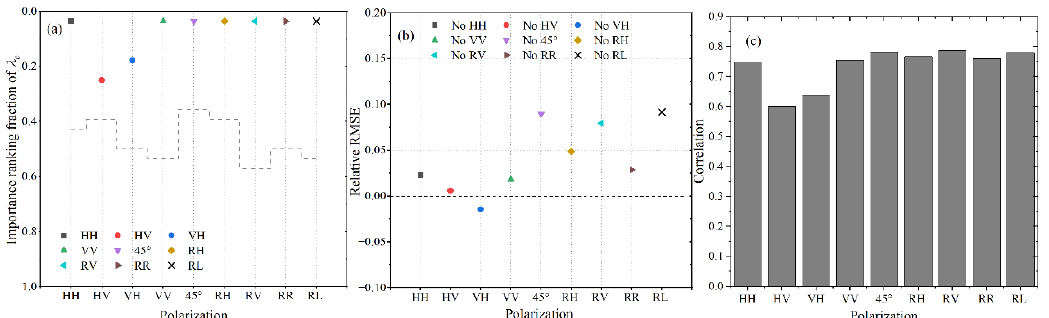
Figure 20. The importance of λ c /β to SWH retrieval from single-polarization models. ( a ) The importance ranking of λ c /β provided by XGBoost models normalized to 0 – 1. The dotted line represents the optimal feature sets under different polarizations. ( b ) The effect of removing λ c /β on the SWH estimation from different polarized models. Different markers in various colors represent λ c /β of different polarizations. ( c ) The correlation between λ c /β and ERA5 SWH under different polarizations.